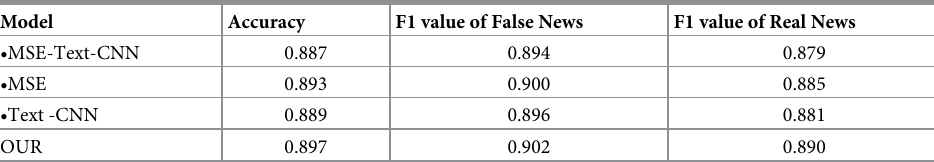
Table 4. Comparative results of ablation experiments on the Weibo dataset